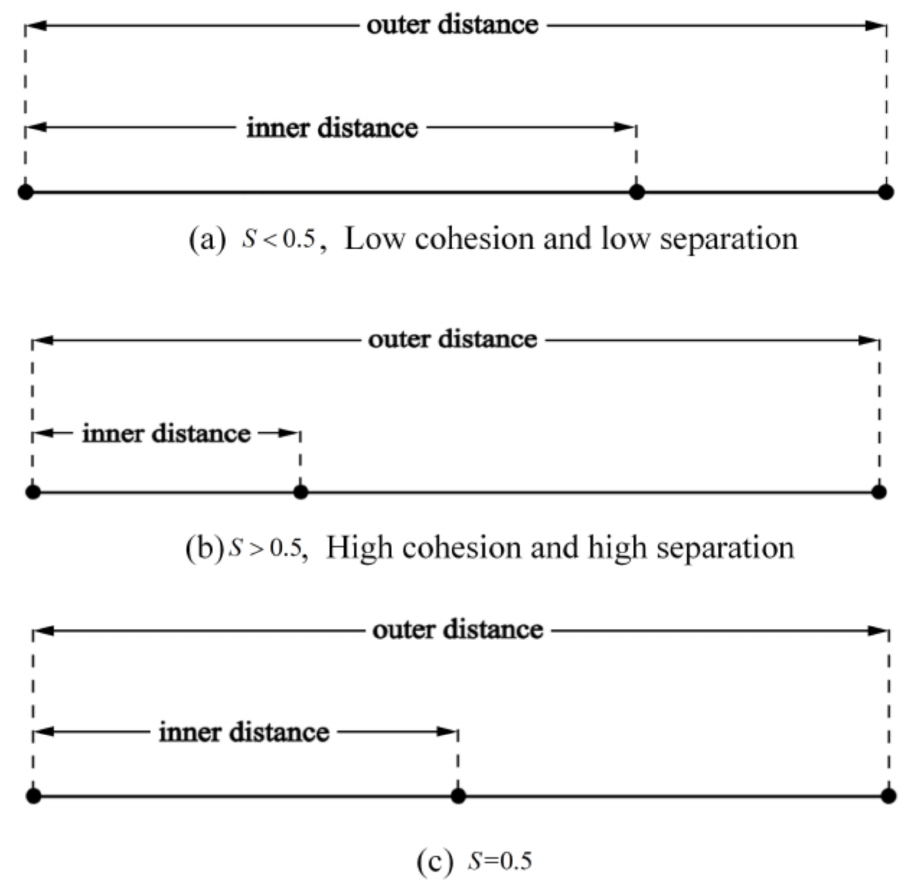
Figure 6. Different values of S